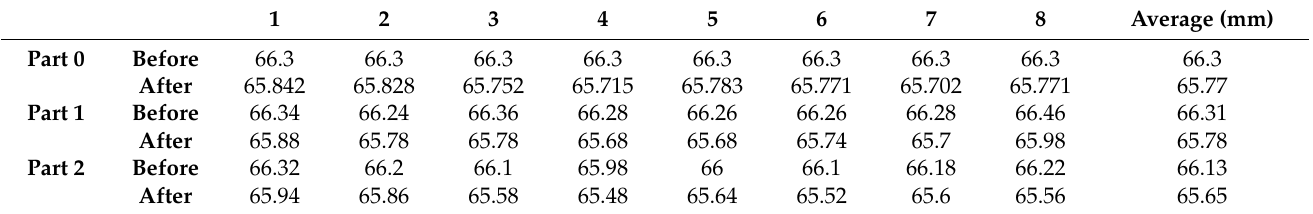
Table 3. Height comparison before and after welding.